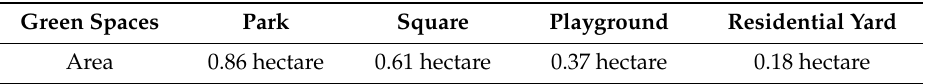
Table 7. The area of the green